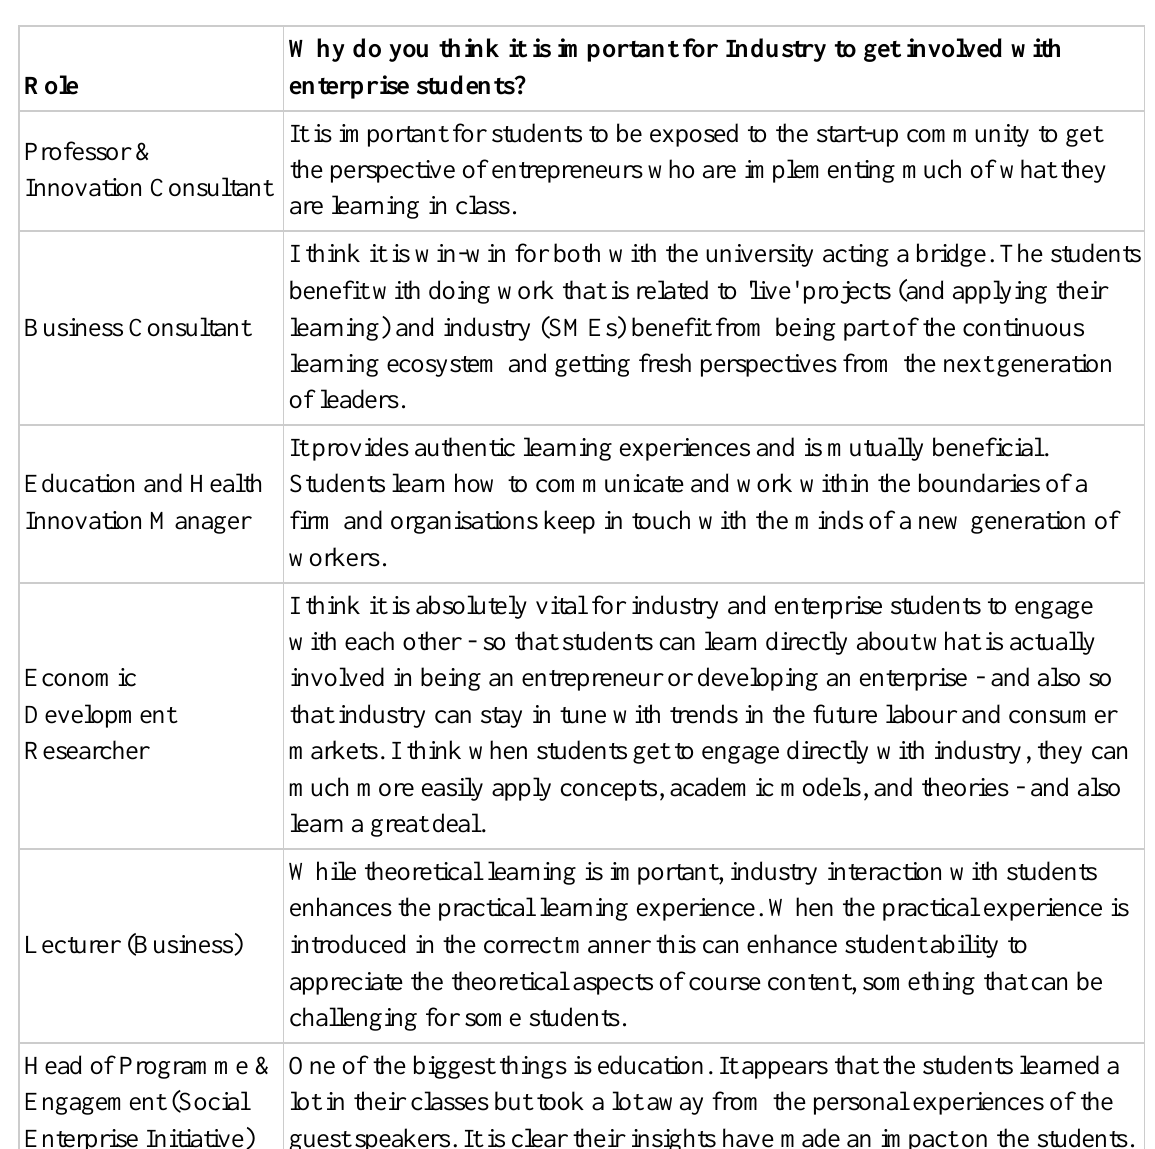
Table 2: Expert Opinion on Industry Engagement Lastly, reviewers were asked to reflect on the activity of attending the guest seminar and the eportfolio assessment itself as a pedagogical tool (See Table 3). All reviewers were in favour of the approach. Members stated the assessment type was ‘novel’, ‘valuable’, encourages more deep level thinking and in fact, may encourage more engagement in the enterprise network and events. The call to connect the experience with academic reading was commended as a way to bring the theory to life, and the guiding questions were also commented on as a good way to move students past rote descriptions of the